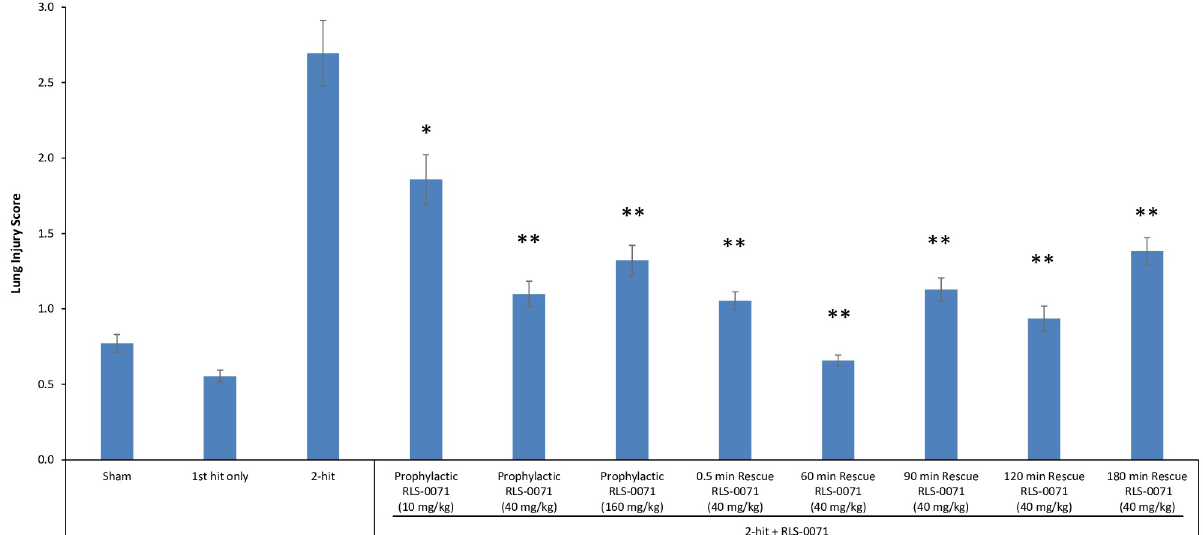
Fig 3. Prophylactic or rescue dosing of RLS-0071 reduces neutrophil-mediated lung injury. H&E stained lung tissue images were converted to black and white and quantified by ImageJ analysis. The ratio of black to white pixels was calculated and used as a measure of lung injury (Y axis). Sham control animals (n = 3), first hit only (n = 2), 2-hit (n = 3), 2-hit + 10 mg/kg prophylactic dose RLS-0071 (n = 4), 2-hit + 40 mg/kg prophylactic dose RLS-0071 (n = 6), 2-hit + 160 mg/kg prophylactic dose RLS-0071 (n = 9), 2-hit + 40 mg/kg rescue dose RLS-0071 at 0.5 min (n = 4), 2-hit + 40 mg/kg rescue dose RLS-0071 at 60 min (n = 3), 2-hit + 40 mg/kg rescue dose RLS-0071 at 90 min (n = 5), 2-hit + 40 mg/kg rescue dose RLS-0071 at 120 min (n = 3) and 2-hit + 40 mg/kg rescue dose RLS-0071 at 180 min (n = 3). Ten images or more were quantified per slide for each animal. Data are means and standard error of the means. Statistical analysis was performed using a Generalized Linear Model. � denotes p = 0.002 and �� denotes p < 0.001 compared to 2-hit animals.